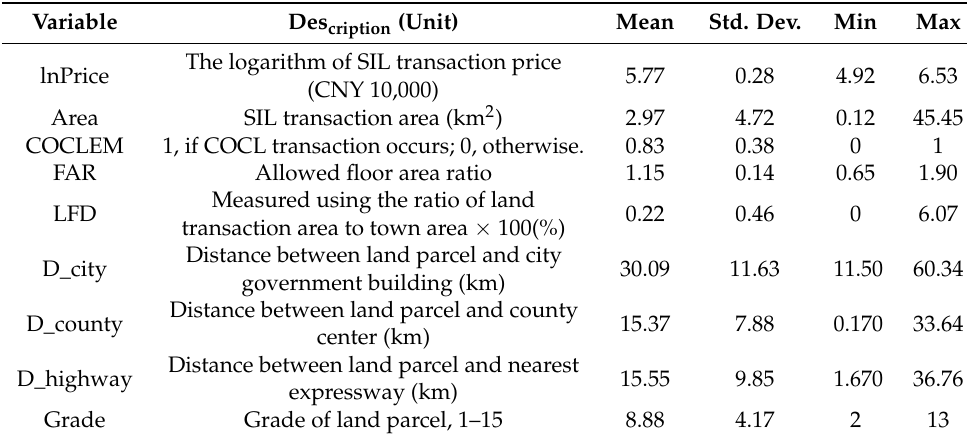
Table 1. Summary statistics of variables in the study area. Variable